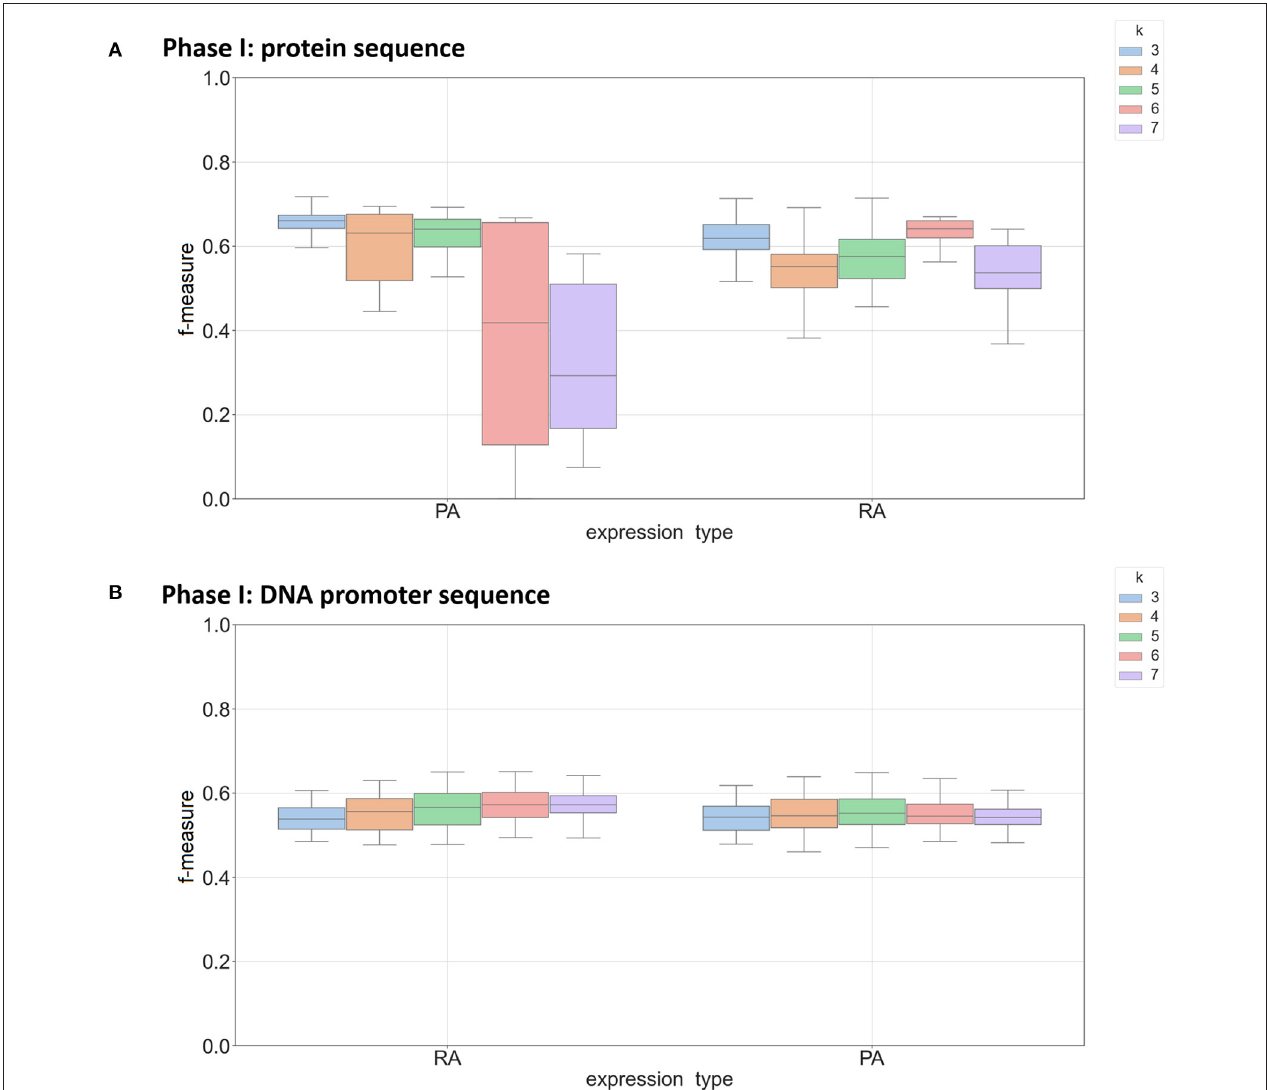
FIGURE 2 | Box plot of F-measures for Phase I classifiers based on k -mer sizes of 3, 4, 5, 6, and 7. Each plot shows the interquartile range and mean of F-measures across all tissues using the top 5–30% and bottom 5–30% of expression cutoffs. Each graph is divided by classifiers predicting mRNA (RA) and protein (PA) abundance. Individual dots are outliers that are outside 1.5 times the interquartile range above the upper quartile or below the lower quartile. Panel (A) shows results using protein sequence as input and panel (B) show results using DNA promoter as